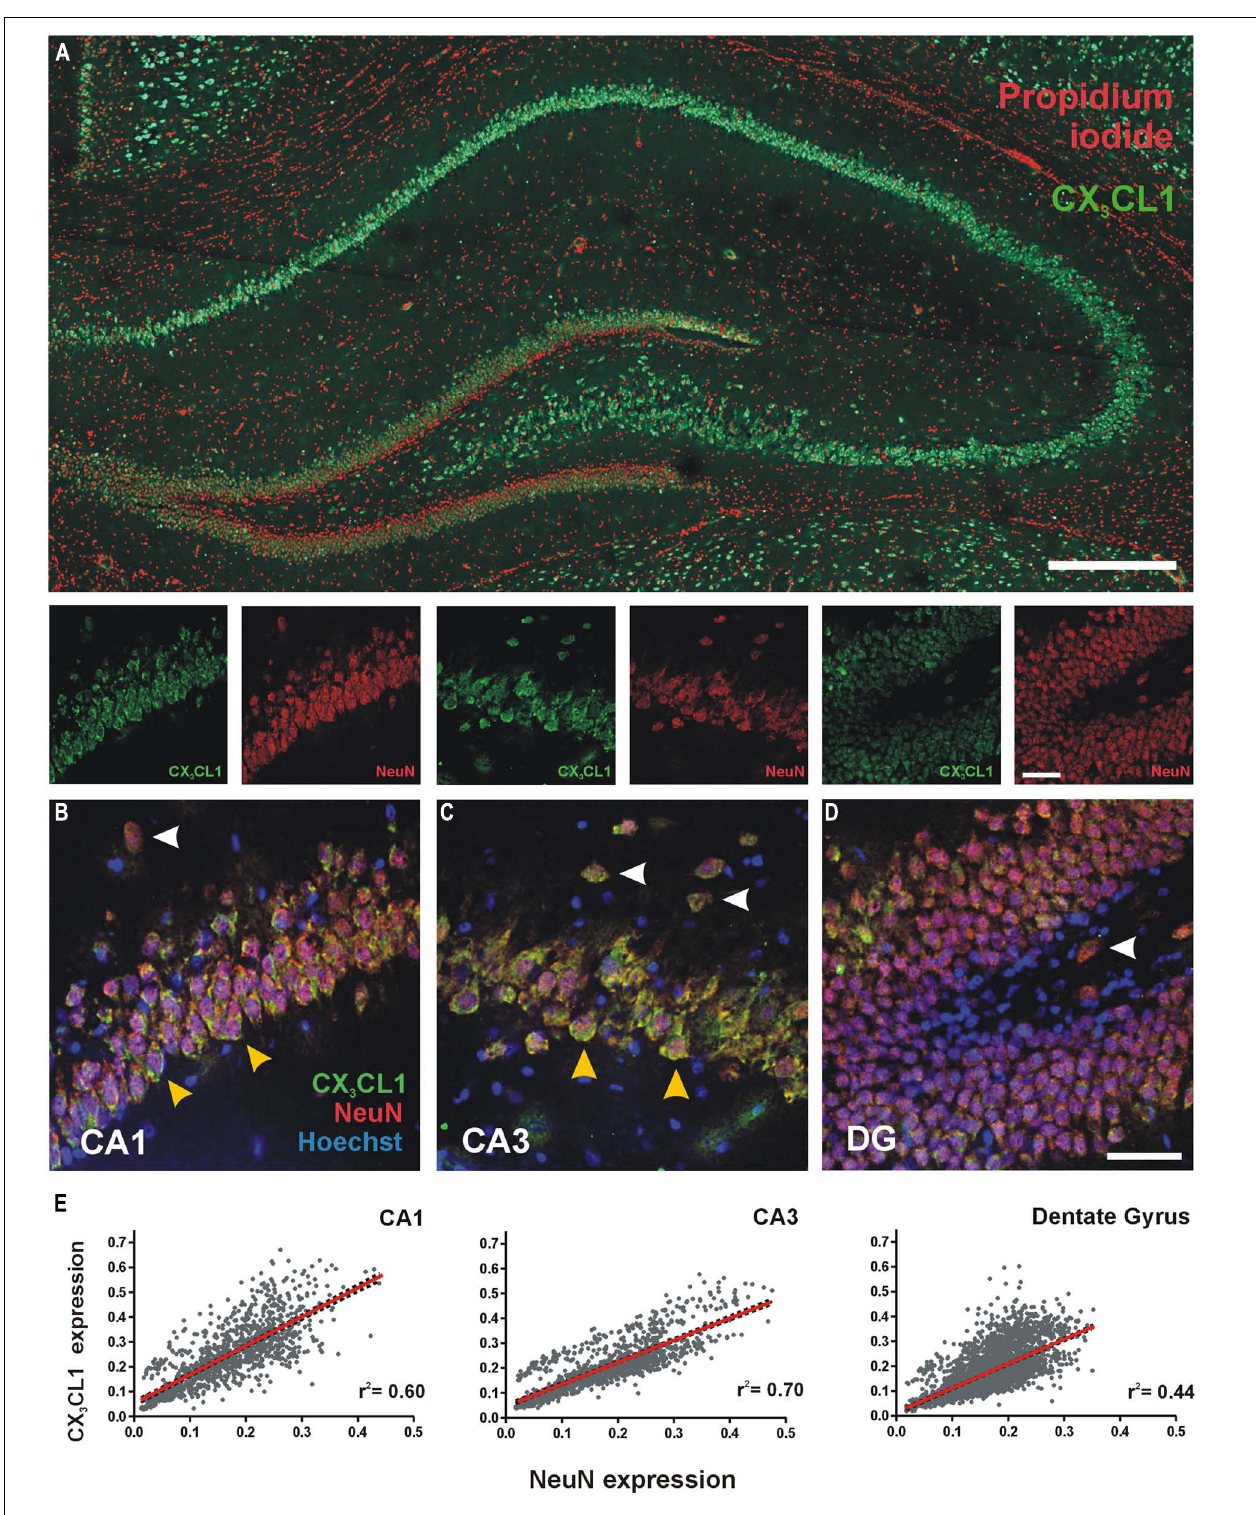
(blue) expression.White arrowheads: interneurons; yellow arrowheads: CA pyramidal neurons. (E) Relationship between CX 3 CL1 and NeuN expression. Each dot represents a single cell. Linear regression analyses (red lines) appear on each plot with corresponding r 2 values indicated. Linear regression p < 0.05 for CA1, CA3 and DG regions of the